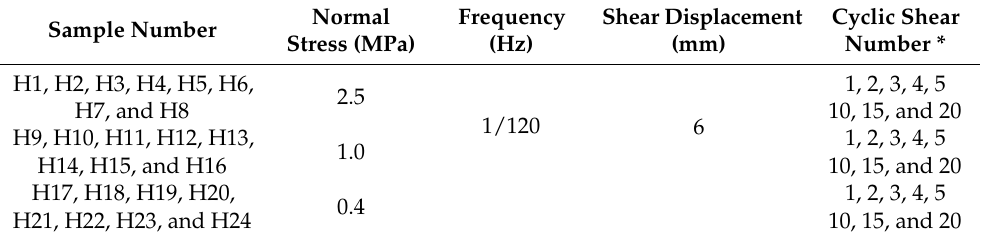
Table 2. Test conditions.